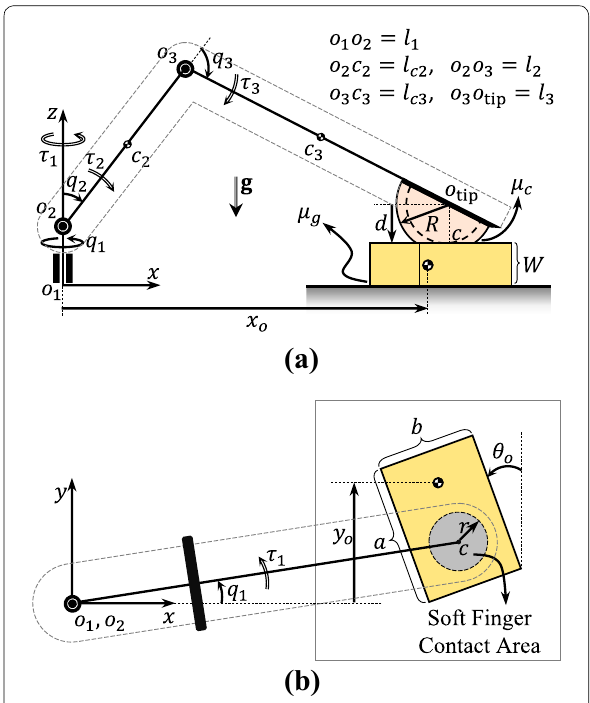
Fig. 5 Object manipulation using a soft finger, a side view, b top view